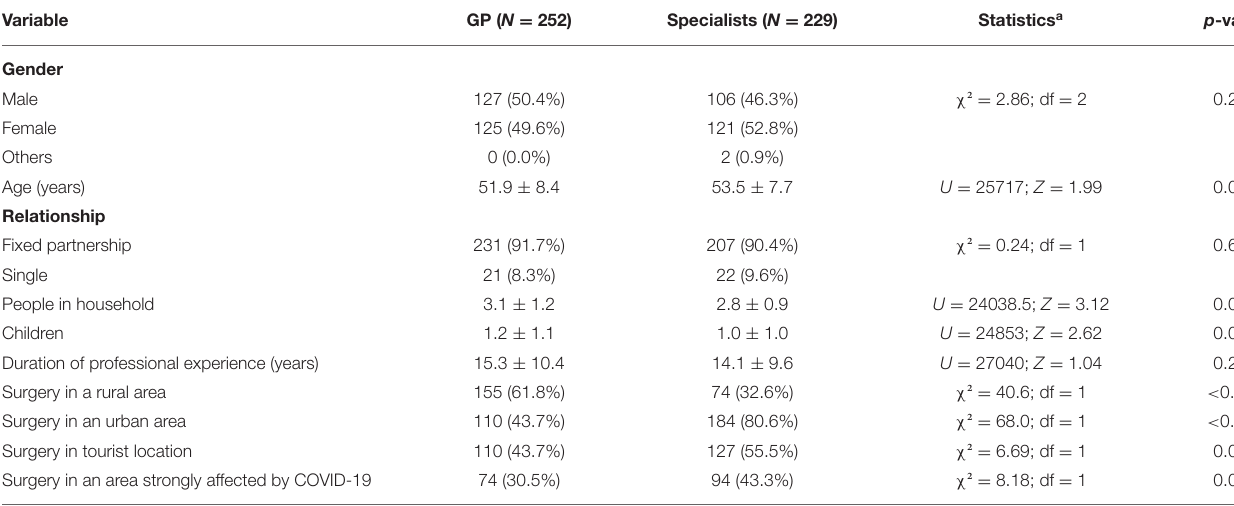
TABLE 1 | Sociodemographic variables ( N =